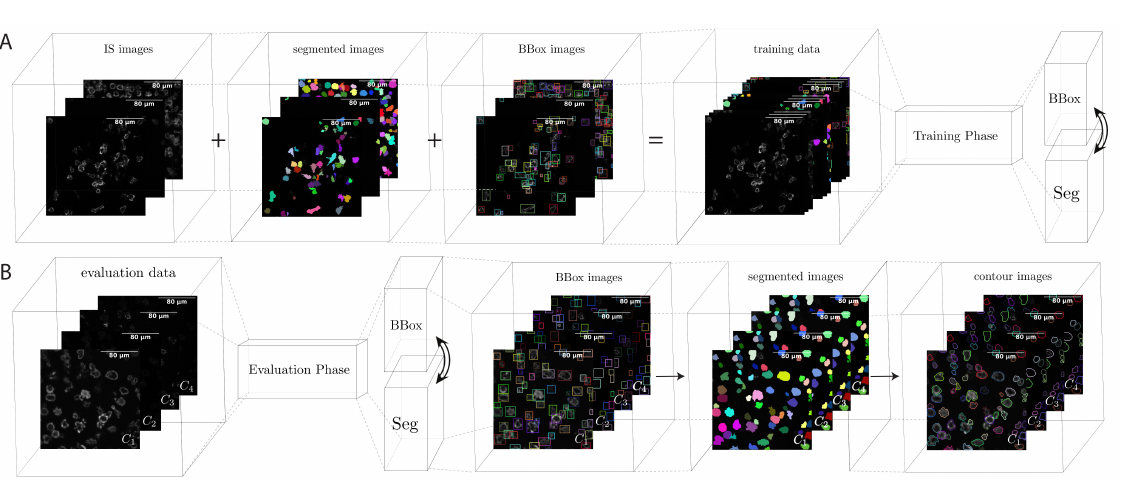
Fig 3. The overall model of instance segmentation for CAR-T cells using multi-scale cell instance segmentation. (A) Demonstrates the training phase. In this phase, CAR-T IS images are used for training sets. (B) Shows the model in the evaluation phase. In this phase, each sample has five channels, of which four of them are applicable for evaluation. Channel 3 is used to select the best Z slide, and Channel 1 provides the best possible representation of the CAR-T IS. From Channel 1, the network produces bounding boxes, instance segmentation, and contours. The generated masks and contours are applied on all channels for statistical analysis.